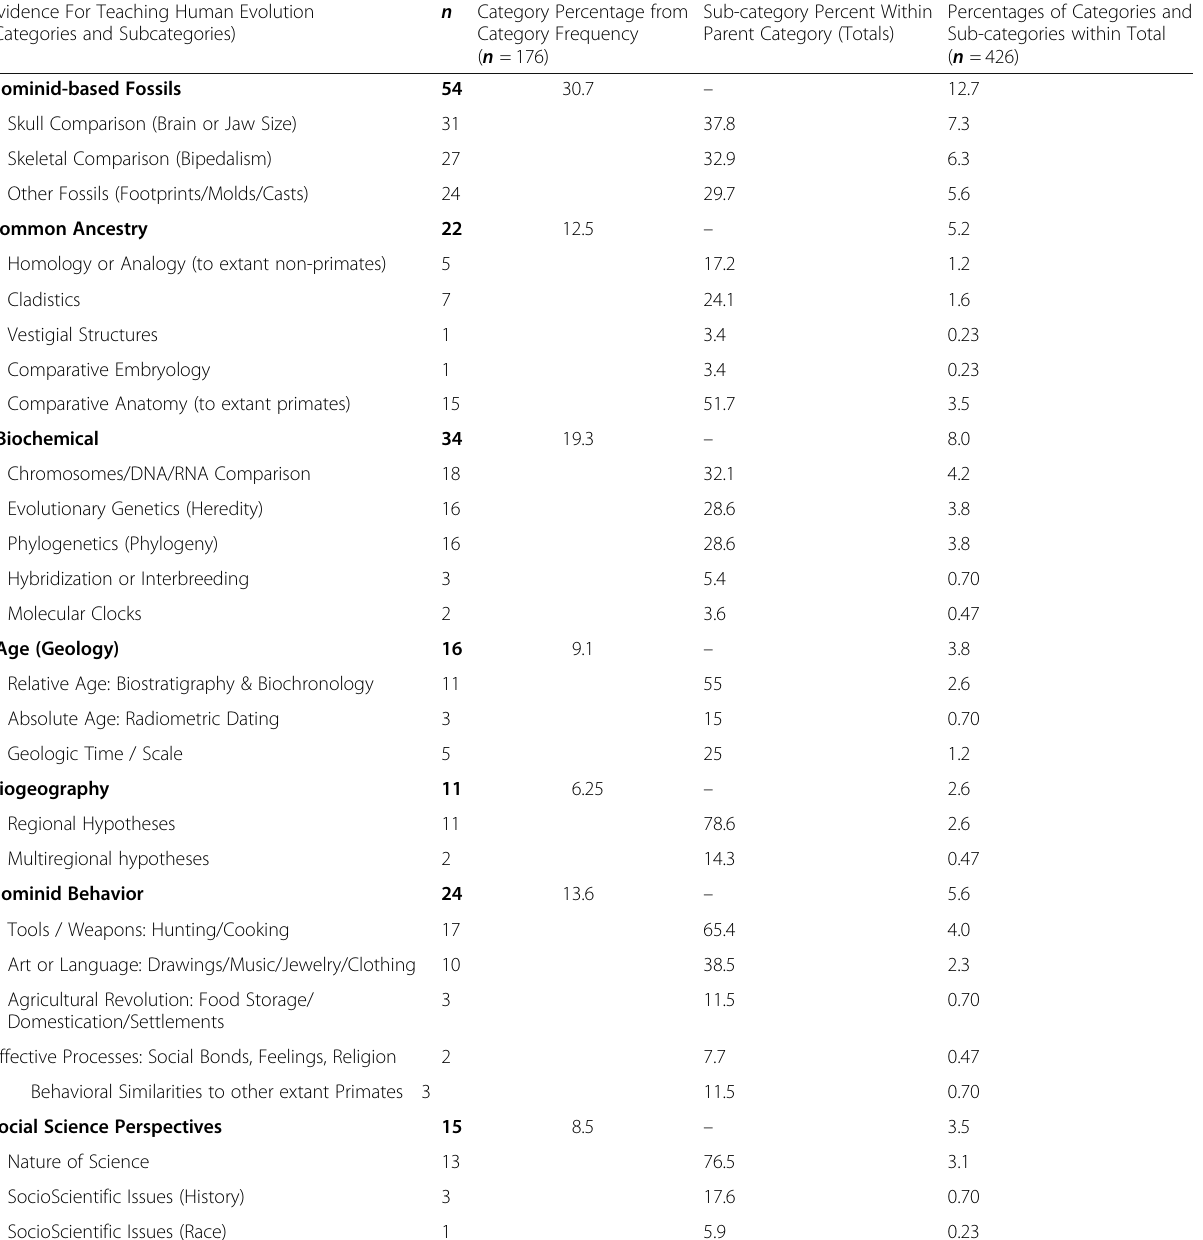
a Indicates categories classified as a source of direct evidence for